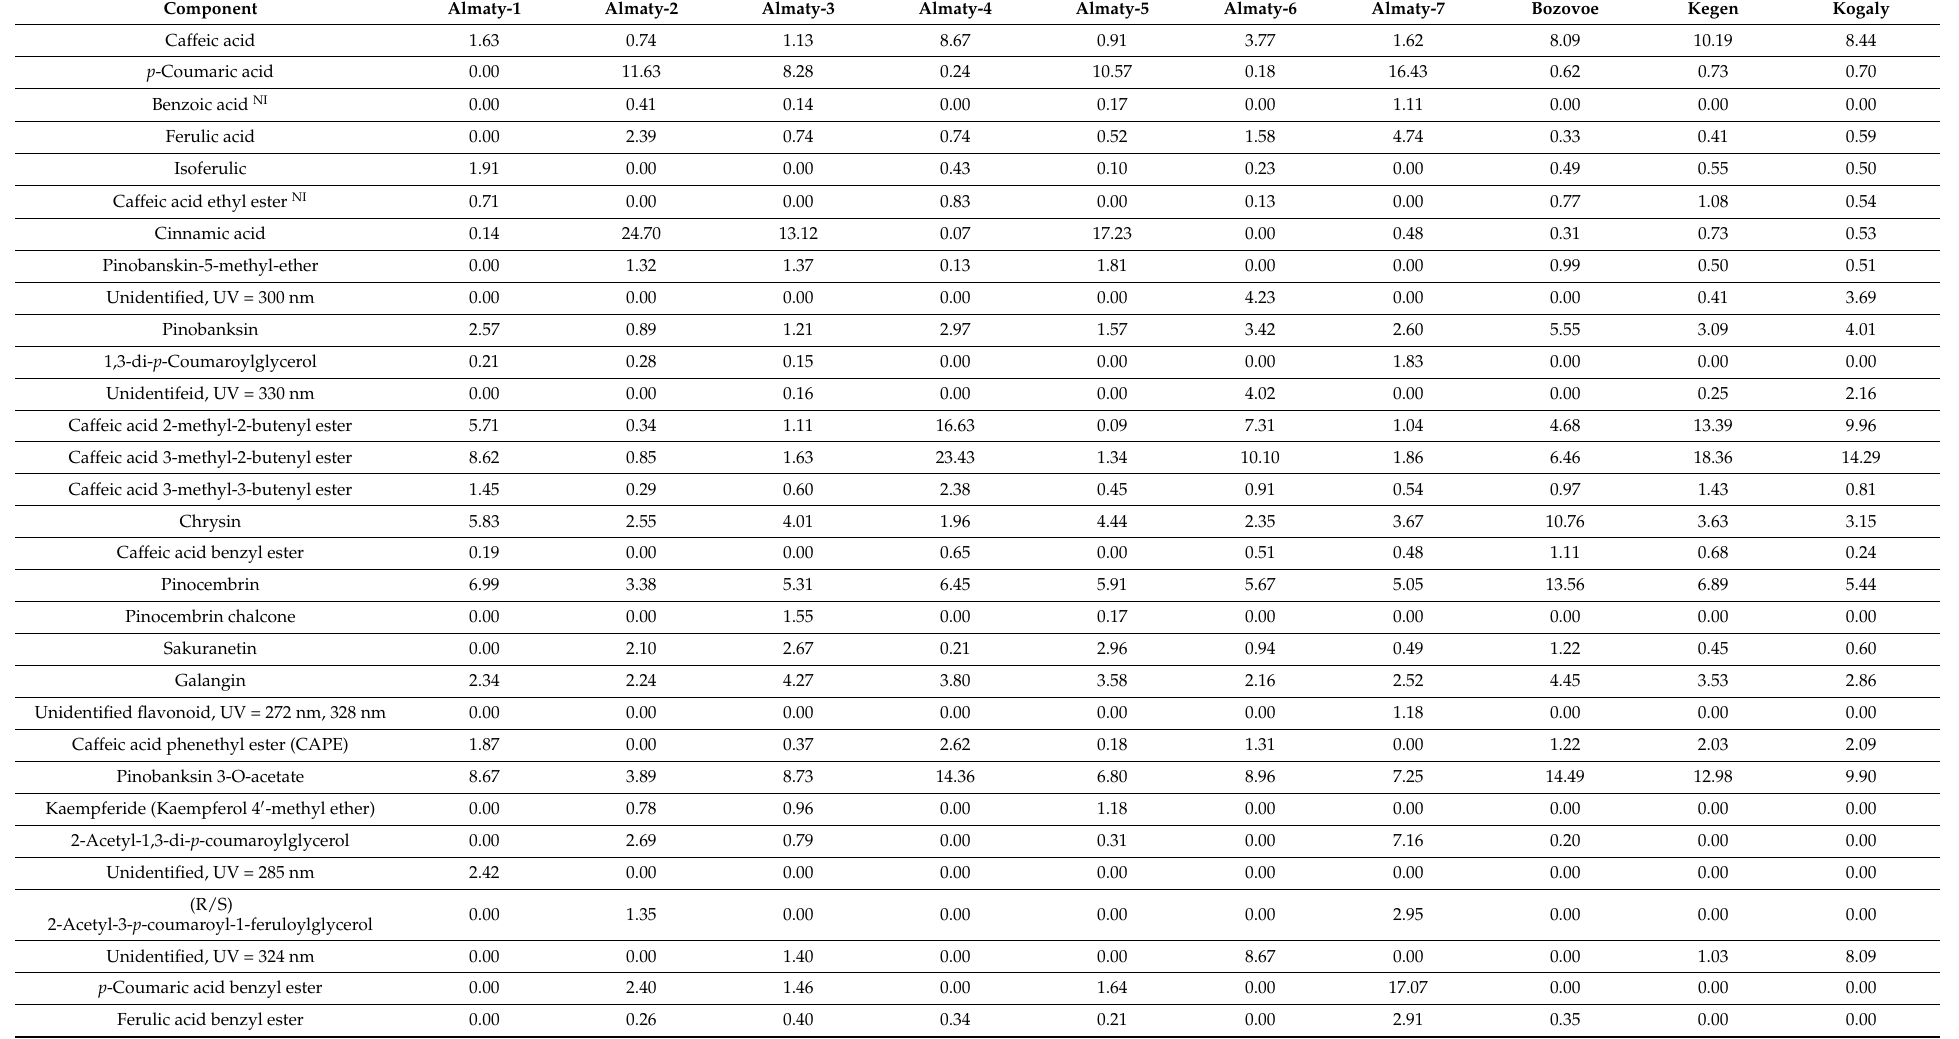
Table 3. Matrix of main components in UHPLC-DAD profile of Kazakh propolis 70% ethanol in water extract in 280 nm